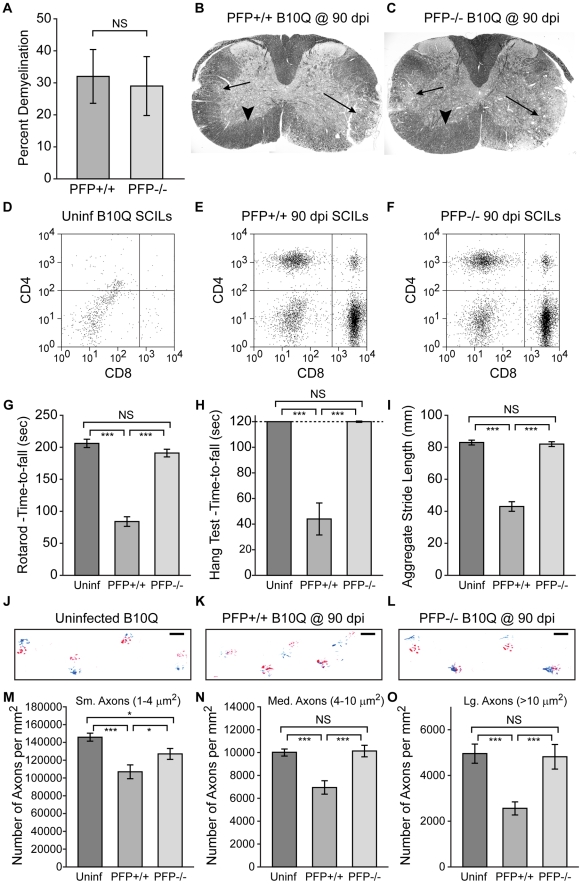
Function and axons are protected in the absence of perforin.Absence of perforin confers protection of motor function and preservation of spinal axons in the demyelinated spinal cord at 90 dpi. All data are presented as mean ±95% C.I. Statistical significance defined as *P<0.05, **P<0.01, ***P<0.001. Significance determined by one-way ANOVA with SNK pairwise posthoc analysis, except demyelination, which was analyzed by t-test. All measurements made at 90 dpi. Uninf  =  uninfected control mice; PFP+/+  =  perforin-competent mice; PFP−/−  =  perforin-deficient mice. (A–C) The percent (A) and distribution (B–C) of spinal cord white matter that was demyelinated did not differ at 90 dpi between perforin-competent (B) or perforin-deficient (C) mice. Arrows indicate demyelinated lesions. Arrowheads indicate normal-appearing white matter. (D–F) Very few CD45hiCD4+ or CD45hiCD8+ leukocytes were present in the spinal cord of uninfected mice (D). No difference in the number of CD45hiCD4+ or CD45hiCD8+ cells in the spinal cord infiltrating leukocytes (SCILs) was observed between perforin-competent (E) and perforin-deficient (F) mice at 90 dpi. (G–I) Motor function as assessed by rotarod (G), hanging wire test (H), and footprint analysis (I) was significantly impaired in perforin-competent mice at 90 dpi but was preserved in perforin-deficient mice at the same time point. (J–L) Representative examples of stride. Scale bar represent 10 mm. (M–O) As with function, small- (M), medium- (N), and large- (O) caliber axons were preserved in perforin-deficient mice as compared to perforin-competent mice at 90 dpi. Medium- and large-caliber axons were preserved to uninfected control levels in perforin-deficient mice.